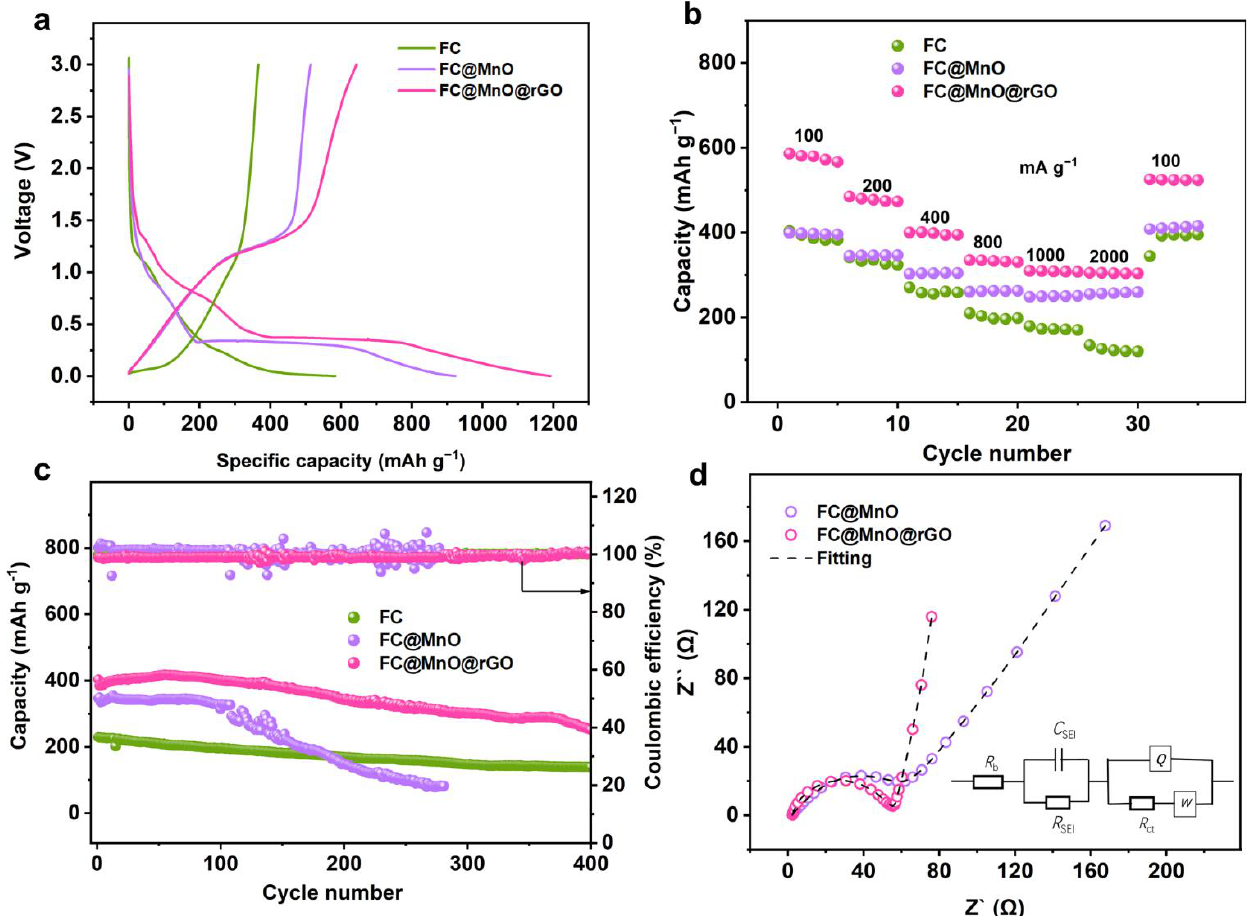
Figure 4. The electrochemical performance of FC, FC@MnO and FC@MnO@rGO. ( a ) The initial gal- vanostatic charge – discharge profiles tested at 50 mA g −1 . ( b ) Rate capability performances at various current densities. ( c ) Stability performances at 400 mA g −1 . ( d ) EIS results and fitting curves